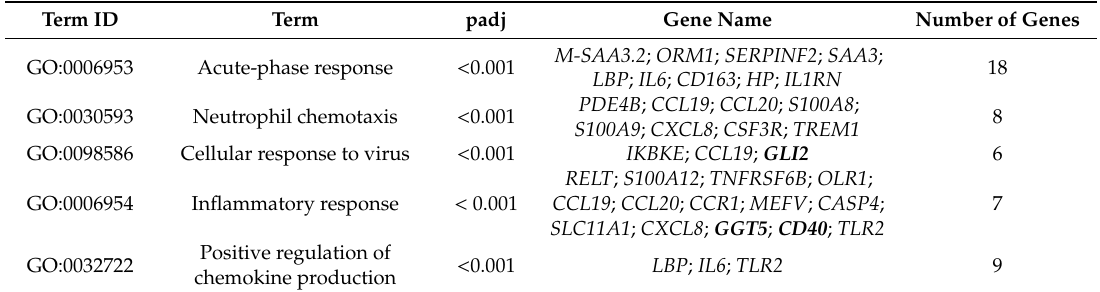
Table 6. Significantly enriched gene ontology (GO) terms related to inflammation and immunity.